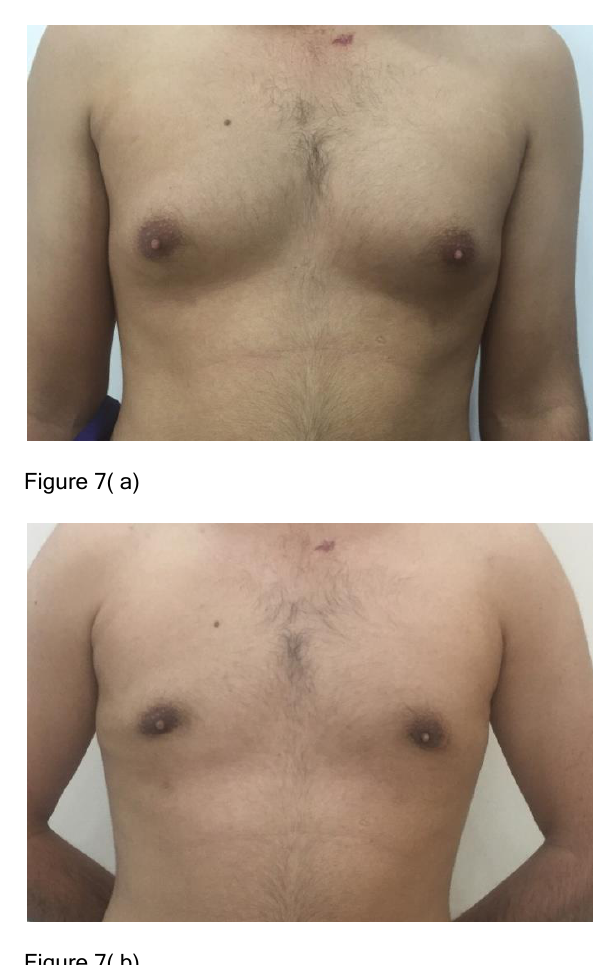
Figure 7 ( a&b) Patient with Simon 2a preoperative and post-operative result